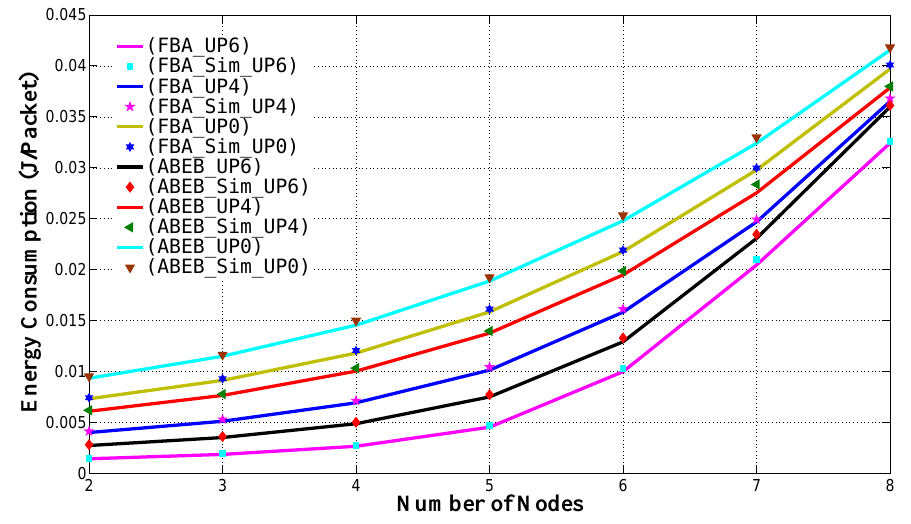
Figure 12. Energy consumption in the homogeneous case for different backoff